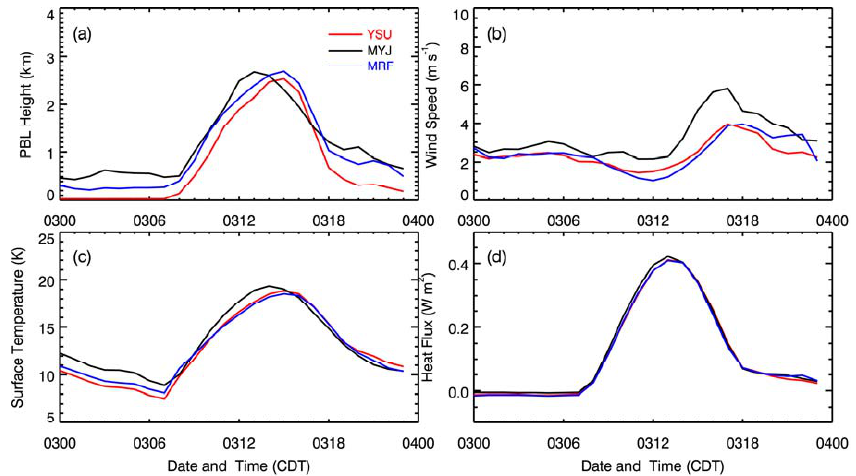
Fig. 12. Same as in Fig. 11, but for (a) PBL height, (b) surface wind speed, (c) surface temperature, and (d) surface heat flux.